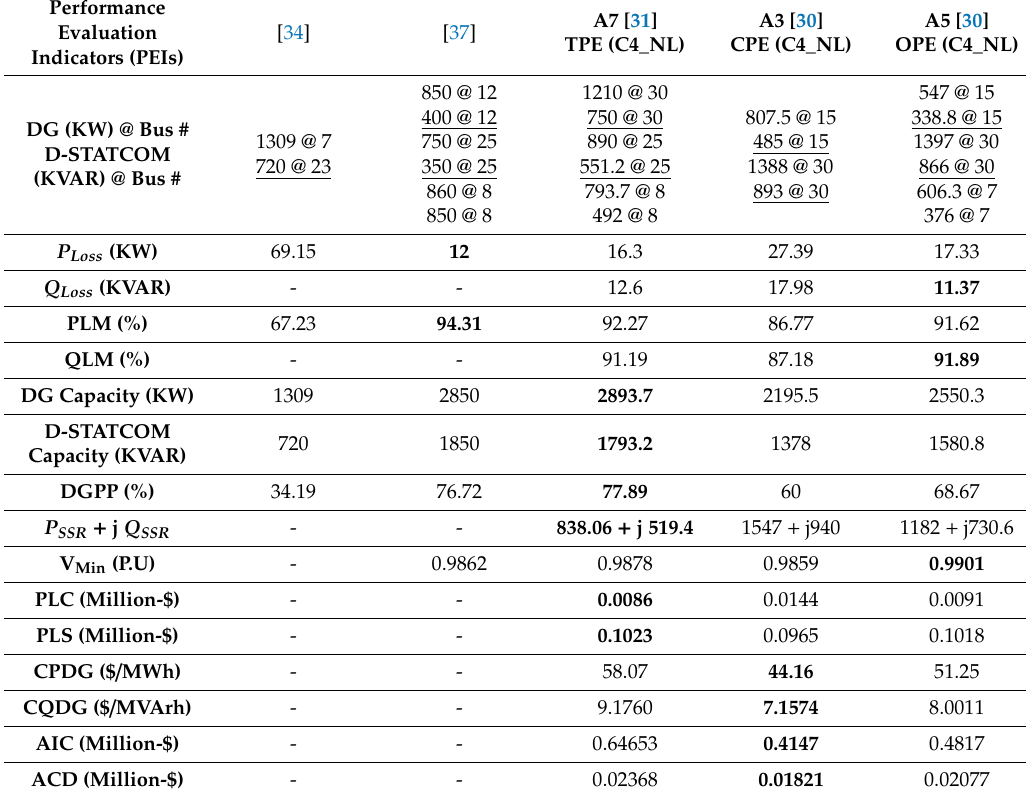
Table 33. Comparisons of results with C4_NL for 33-bus TDN (REG + D-STATCOM@LPF = 0.85). Performance